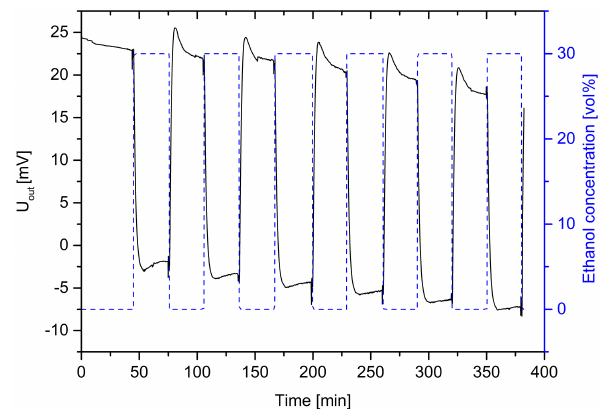
Figure 9. Output voltage of the piezoresistive hydrogel-based pres- sure sensor for cyclic changes in the ethanol concentration (hydro- gel: 10vol%Aam and 0.44mol%Bis; sensor setup: 250µm hydro- gel with silicon